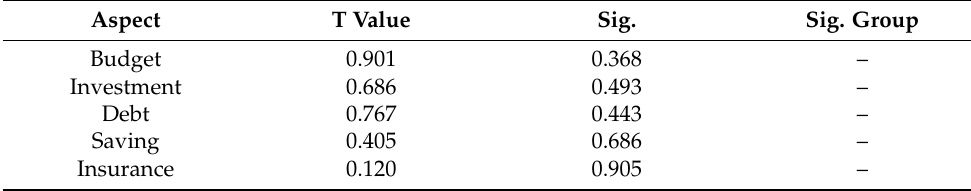
Table 9. Differences according to gender using the independent samples T-test ( n = 887). Aspect T Value Sig. Sig. Group